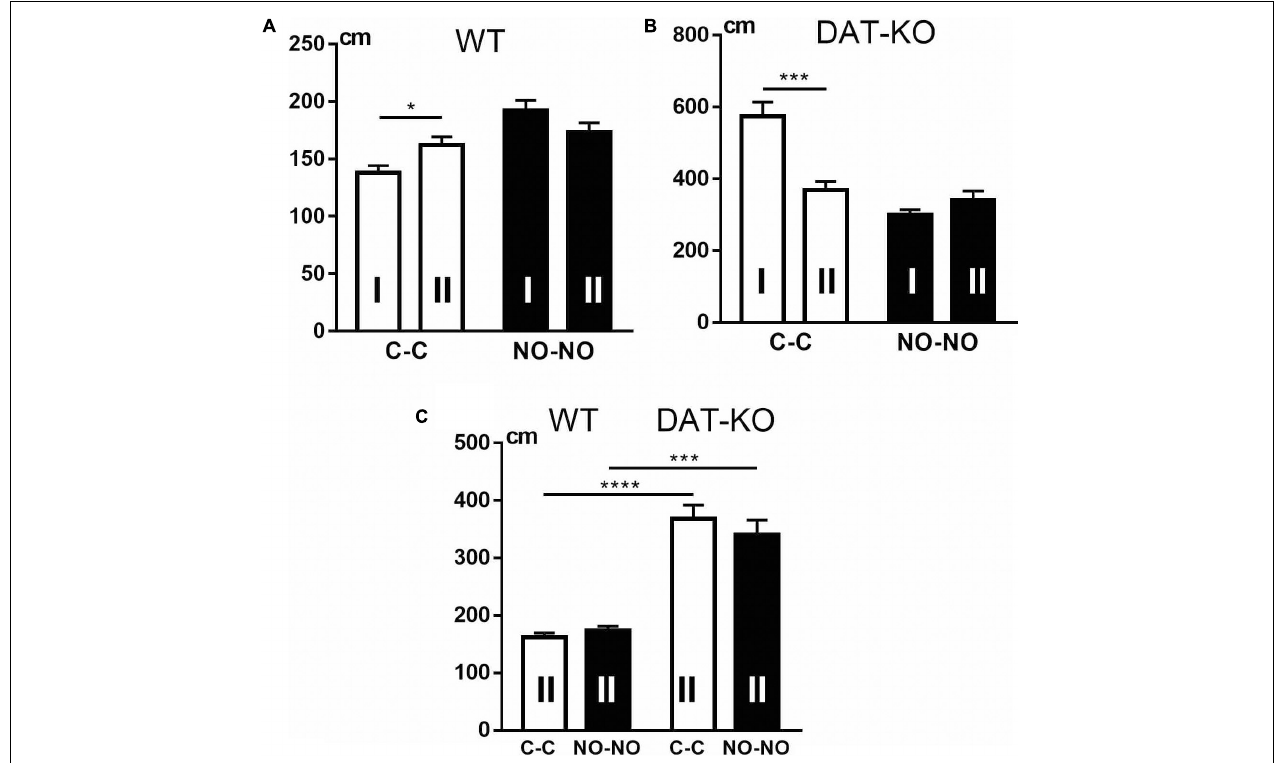
FIGURE 6 | Comparison of distances covered by WT (A,C) and DAT-KO rats (B,C) in the first (I) and second (II) blocks of experiments. White columns, cube presentations (C-C); black columns, novel object presentations (NO-NO); * p < 0.05; *** p < 0.001; **** p < 0.0001; one-way Kruskal–Wallis test with Dunn’s multiple-comparison post hoc test. WT, wild-type; DAT-KO, dopamine transporter knockout.